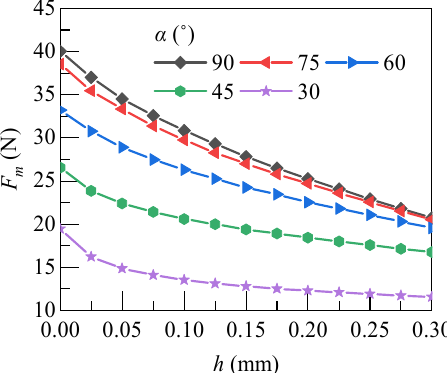
Figure 12. Static electromagnetic force varies with α .